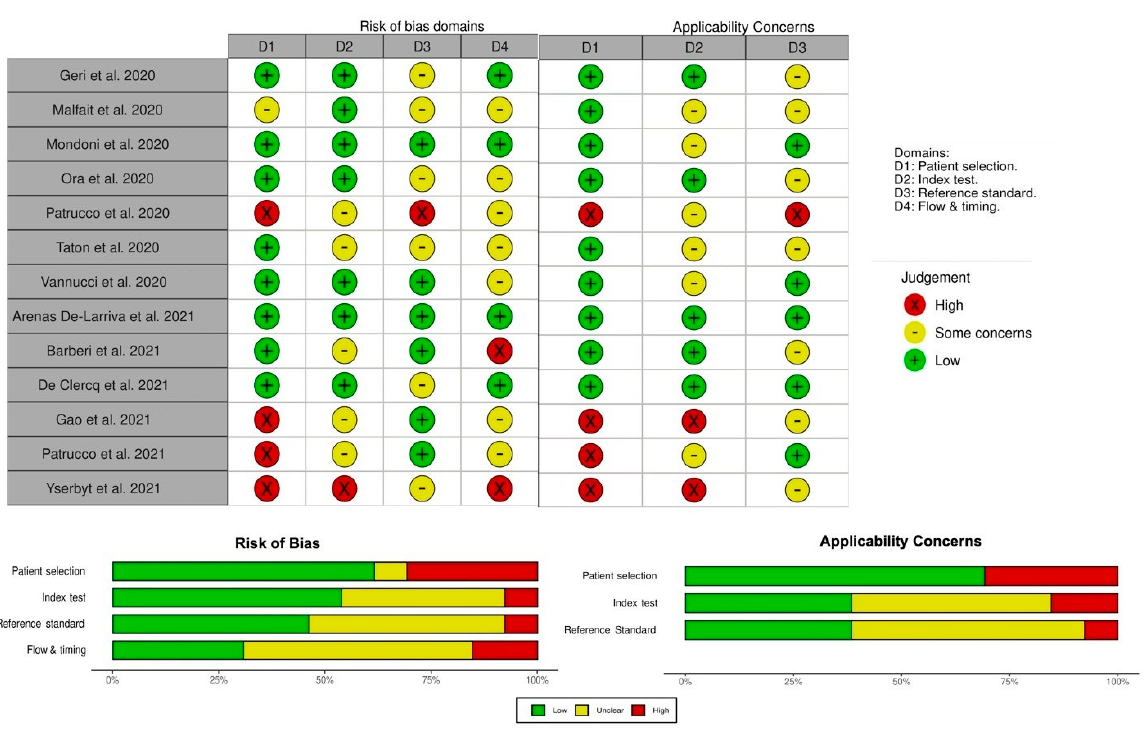
Figure 4. Graphical display of the revised Quality Assessment of Diagnostic Accuracy Studies (QUADAS-2) results, according to risk of bias and applicability concerns [4–16].